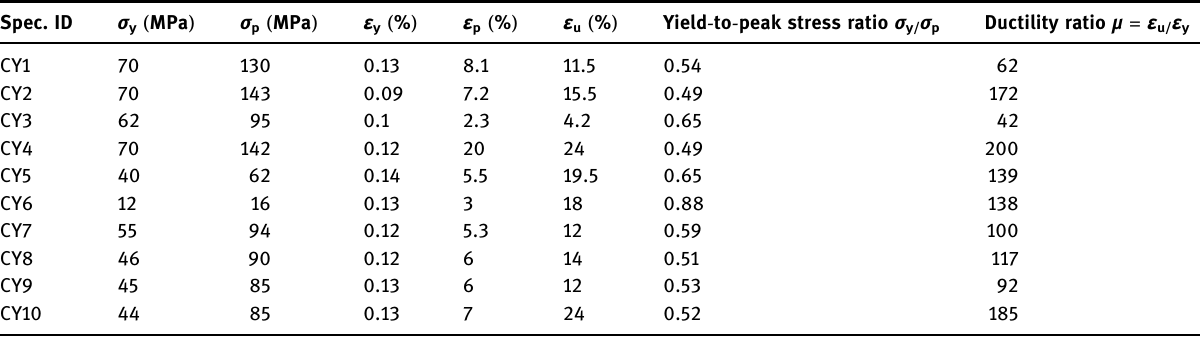
Table 2: Summaries of strength, strain, and ductility Spec.